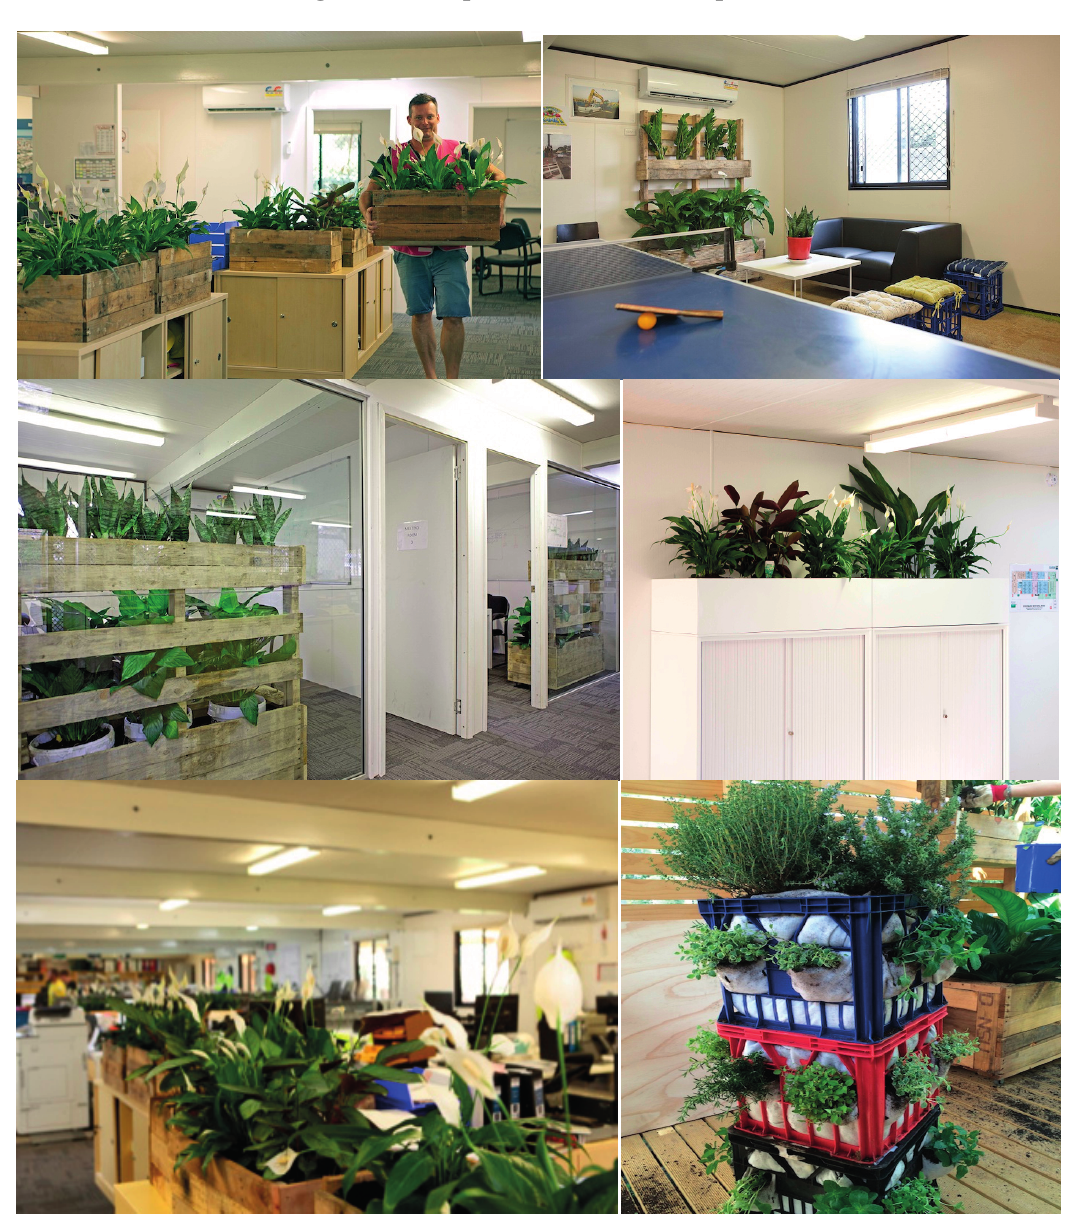
Figure 6. The plants enter the